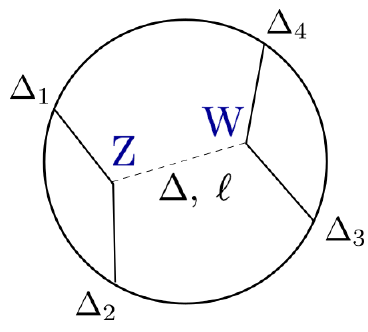
Figure 1 . An exchange Witten diagram.